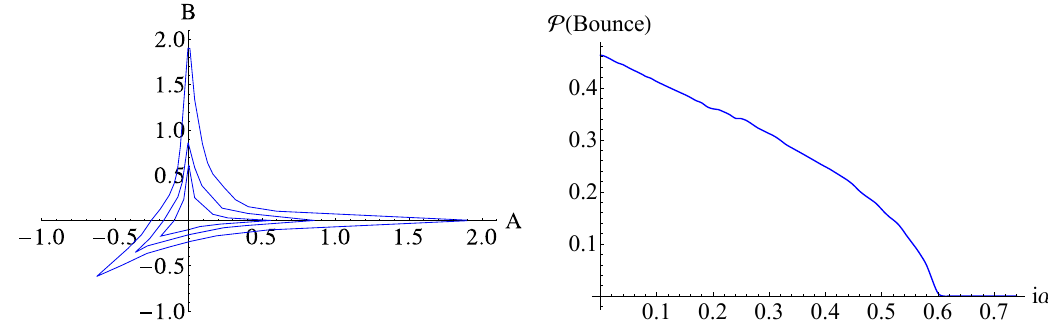
Figure 12. Left panel: the three contours bound the region in the ( A; B ) plane for which an approximately classical bounce occurs for (from small to large) resp. (cid:11) = 3 = 8 i , (cid:11) = i= 4 and (cid:11) = 0. Right panel: the total probability for a semiclassical bounce as a function of (cid:11)